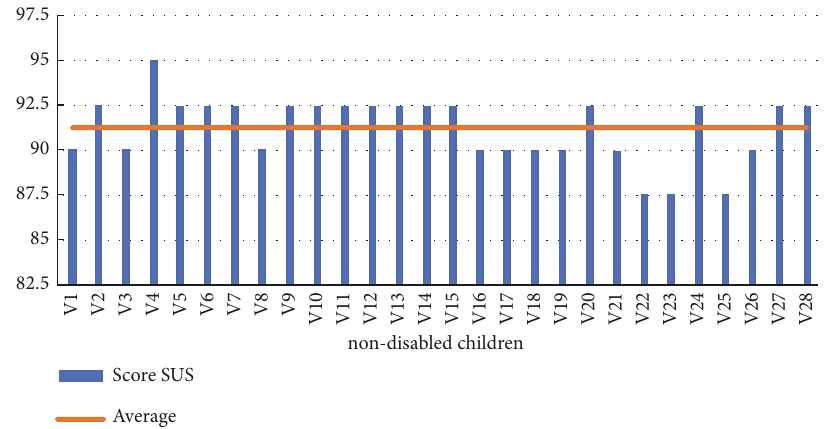
Figure 24: Result of the ALTRIRAS usability test performed by the non-disabled children.